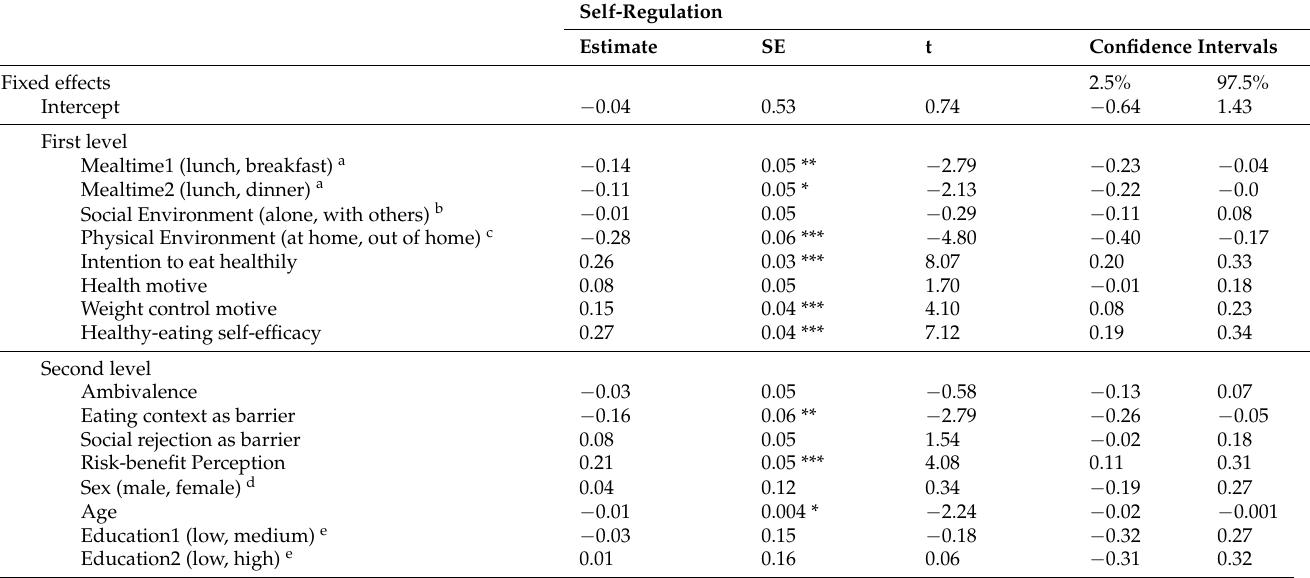
Table 3. Estimated model fixed